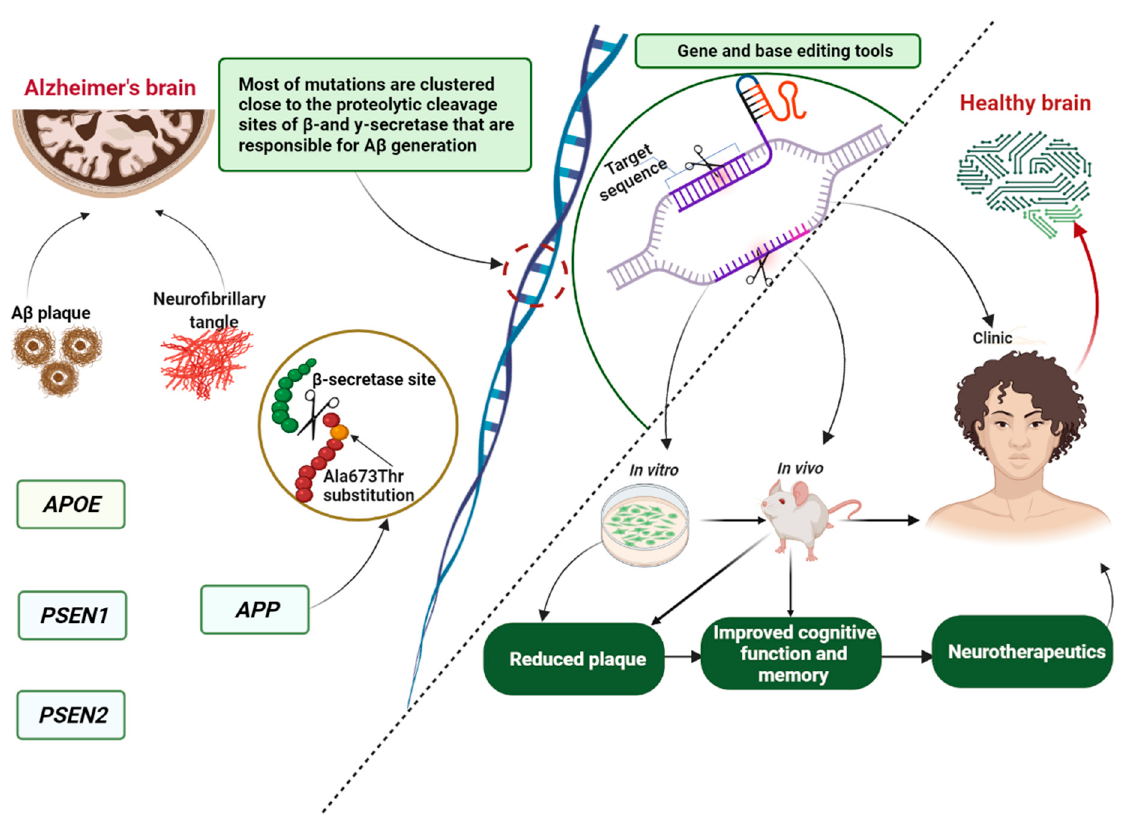
Figure 3. Schematic representation of the involvement of the Icelandic mutation in Alzheimer’s disease regarding genome editing tools. The figure was prepared with BioRender. APP, amyloid precursor protein; A β , amyloid-beta peptide; PSEN1, presenilin 1; PSEN2, presenilin 2; APOE, apolipoprotein E.